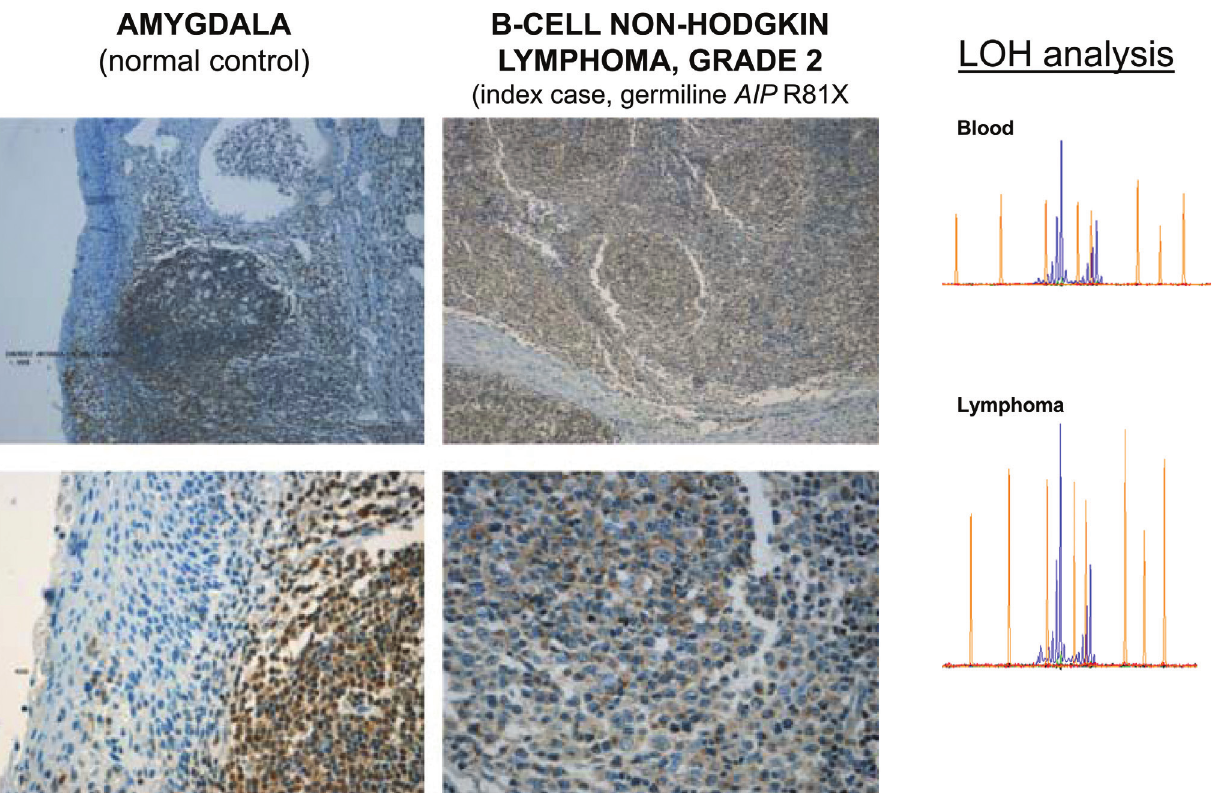
Figure 4 - Maintenance of heterozygosity and positive AIP immunostaining in the B-cell non-Hodgkin lymphoma of the R81X AIP mutated IFS patient.